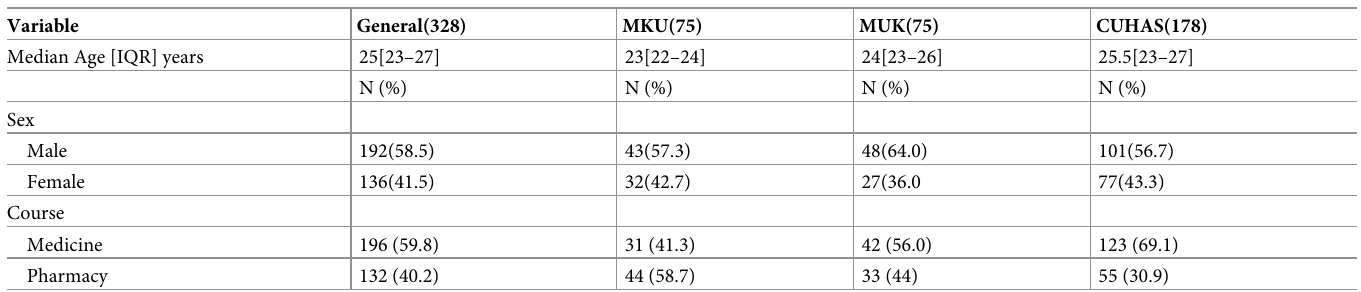
Table 1. Socio-demographic characteristics of